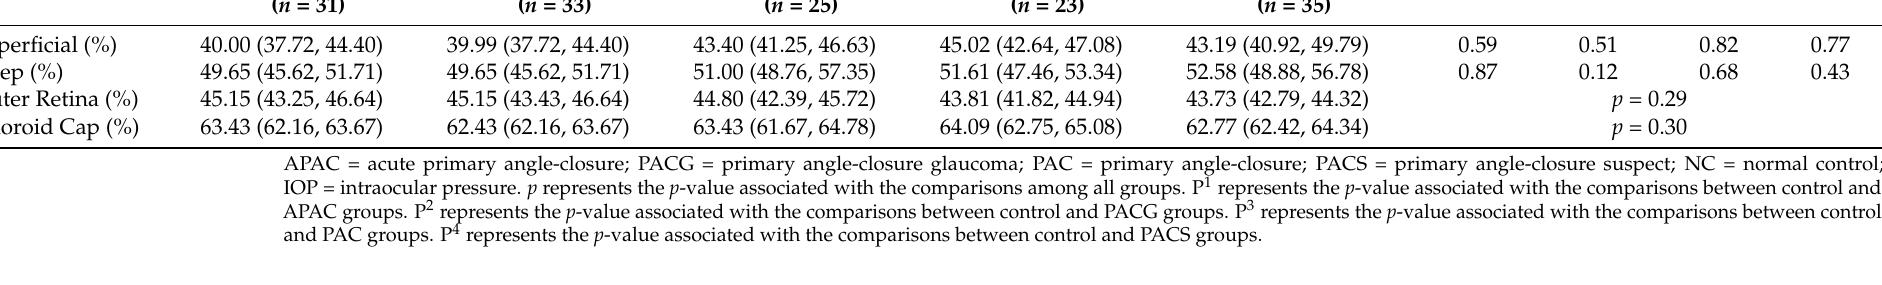
Table 5. Whole image vessel density (wiVD) of the superficial